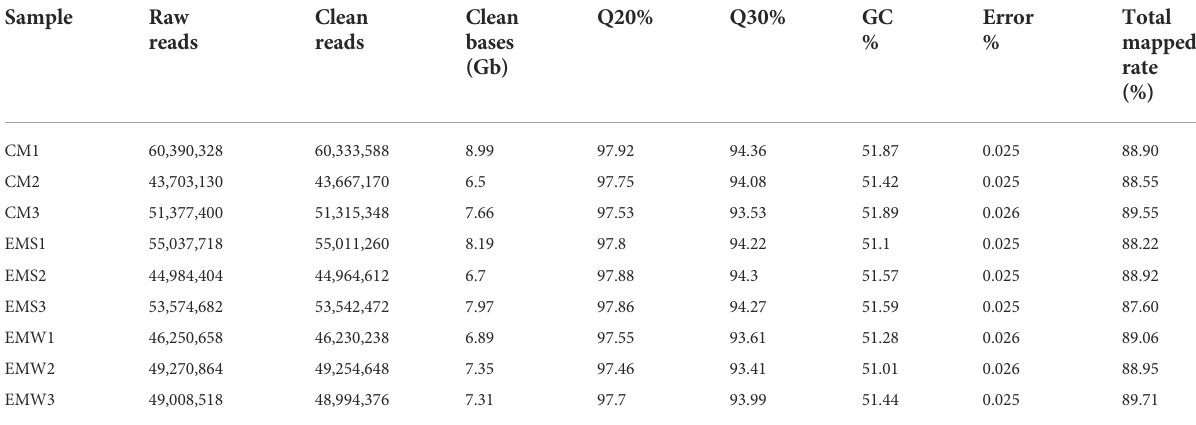
TABLE 1 Overview of the RNA-seq library of E. coioides . Sample